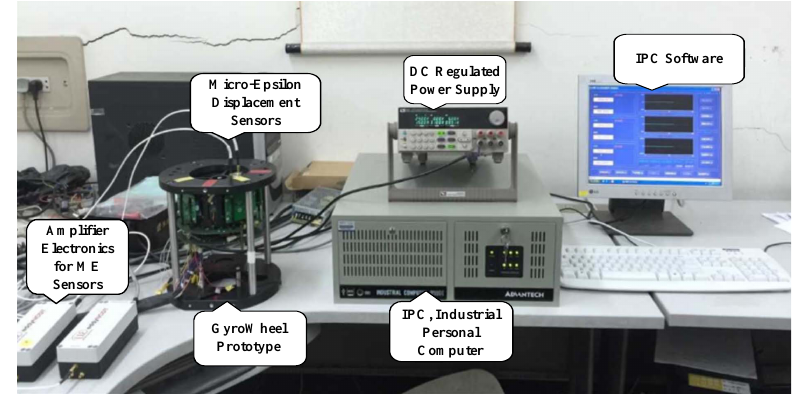
Figure 13. Experimental platform of the GyroWheel